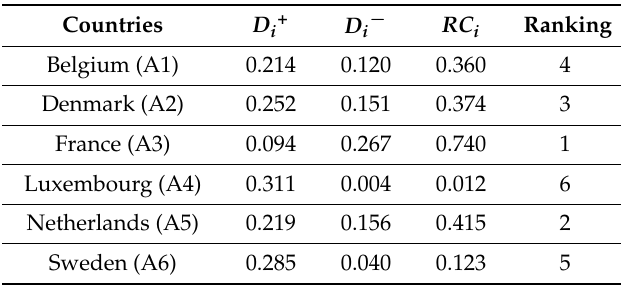
Table 14. Ranking results of the international transport export including energy trade for the selected EU countries in